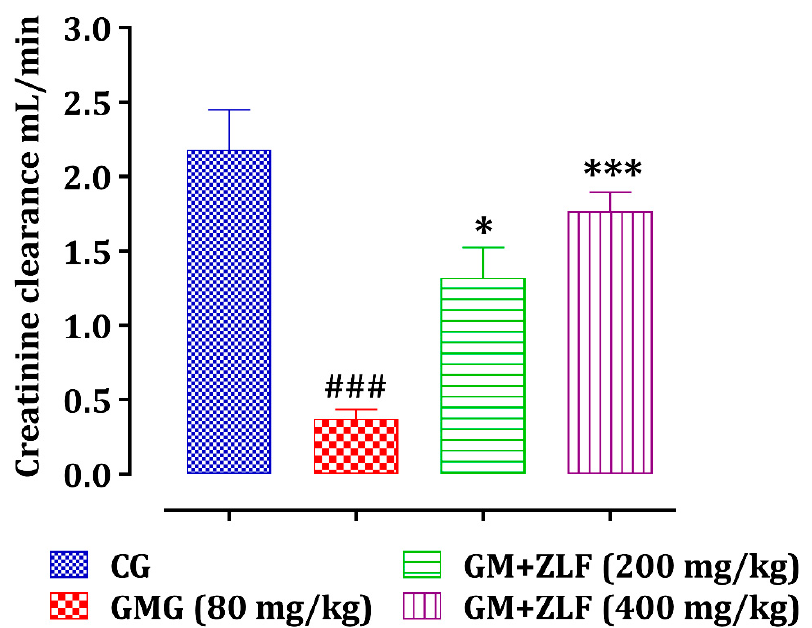
Figure 5. Effect of ZLF’s on creatinine clearance in GM-exposed rats. The data are presented as mean ± SEM, ( n = 6). ### p ≤ 0.001, versus CG. * p < 0.05, *** p < 0.001 versus GMG. GM: gentamicin; CG: Control Group; GMG: GM treated Group.